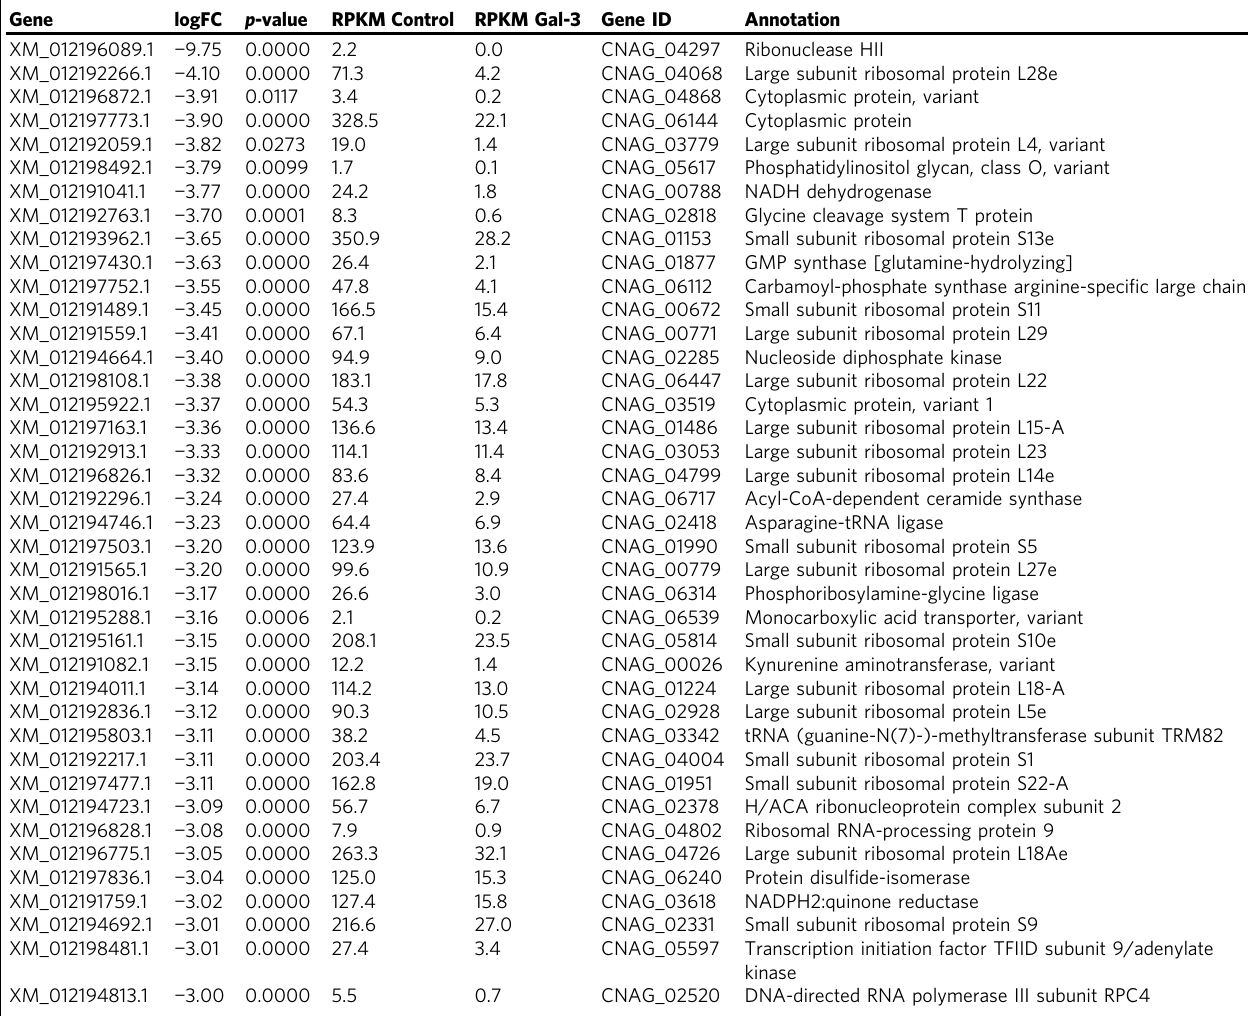
Table 2 List of top 40 repressed genes with annotated functions upon exposure to Gal-3